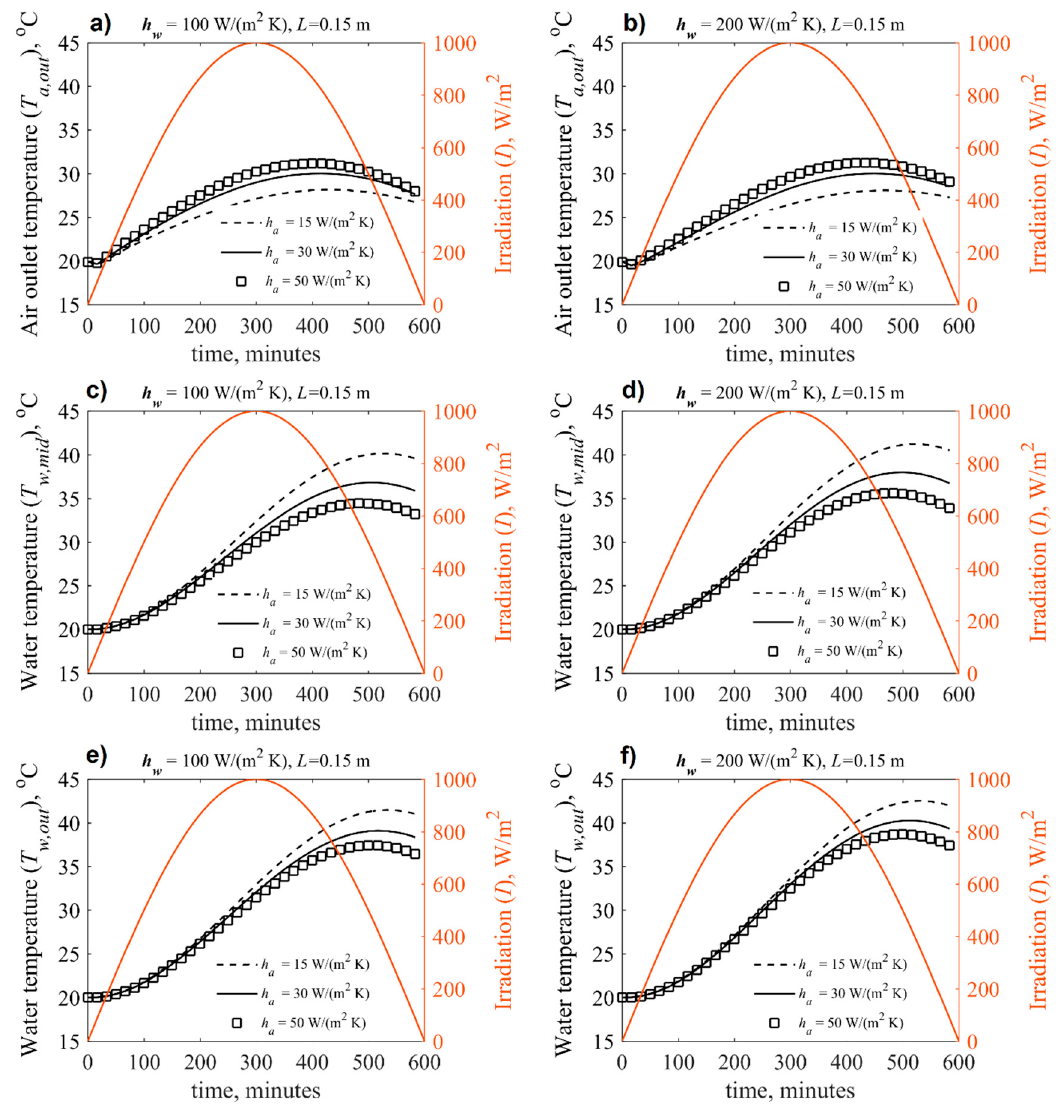
Figure 5. The variations of air outlet temperature ( a , b ), at mid-height ( c , d ) and top ( e , f ) of the tank’s water temperature for tank width of 0.15 m. Subfigures ( a , c and e ) are obtained for h w = 100 W/(m 2 · K) while subfigures ( b , d and f ) are obtained for h w = 200 W/(m 2 ·K).